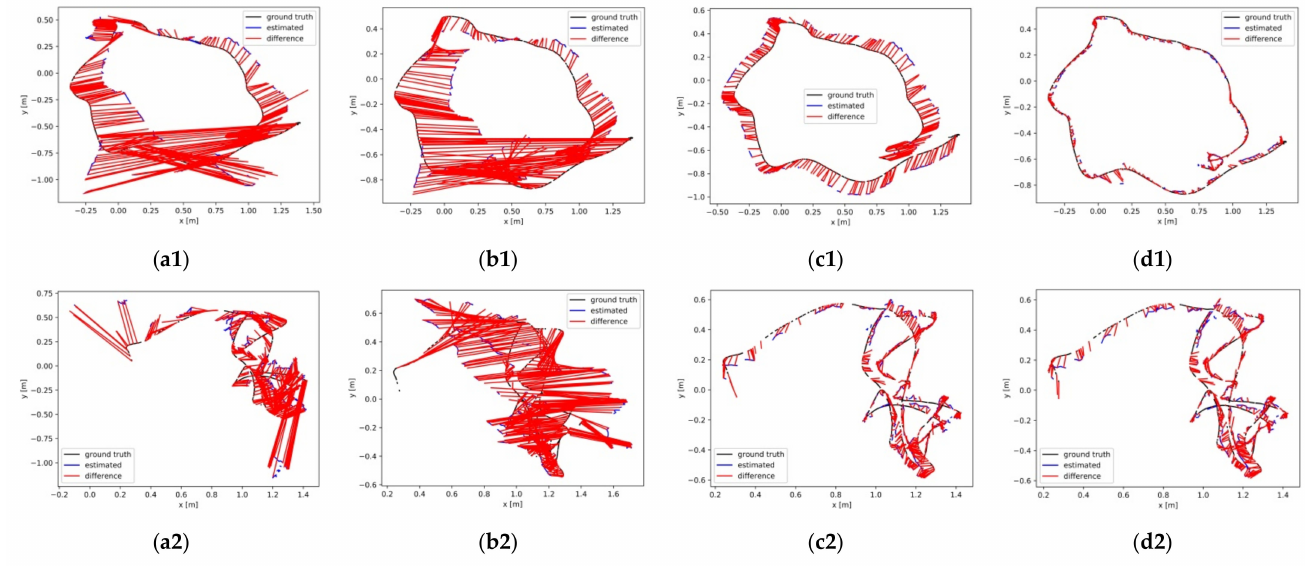
Figure 14. Comparisons of ATE-RMSE on two real dynamic scene sequences, “Seq01-02”. ( a1 , a2 ) OPF- SLAM; ( b1 , b2 ). ORB-SLAM2; ( c1 , c2 ) Dyna-SLAM; ( d1 , d2 ) PFD-SLAM.